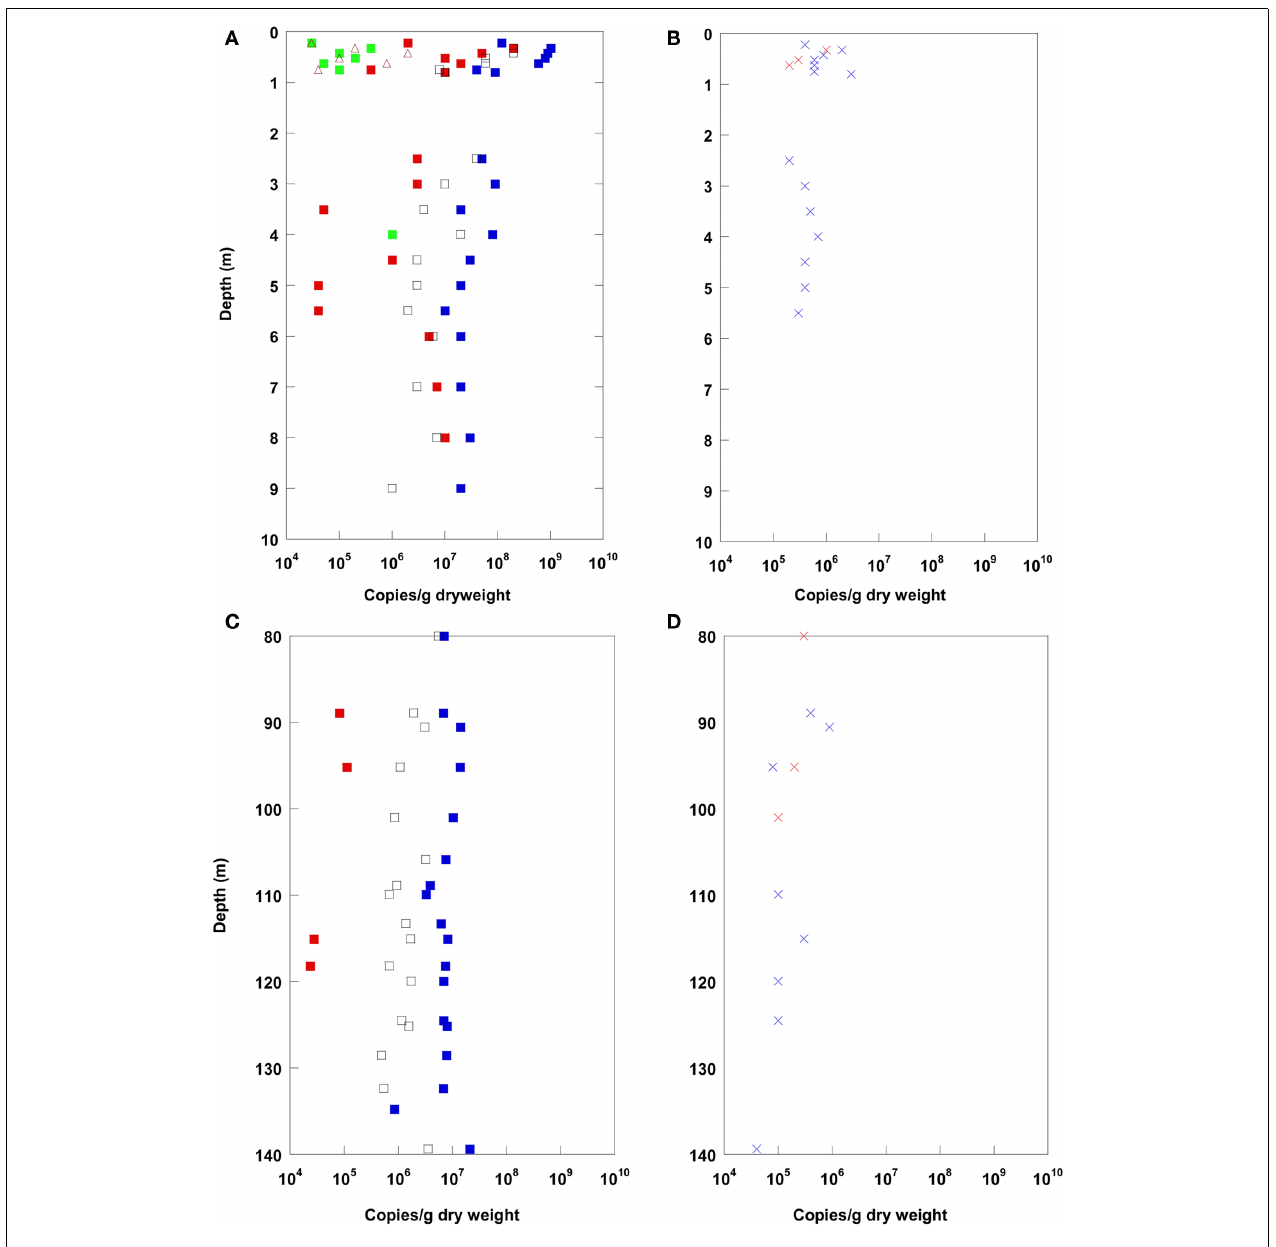
Bacteria , red: Archaea , green: Eukarya , brown: Geobacteriaceae , black: JS-1- Chloroflexi (A,C) ; functional genes, red: aprA , blue: cbbL (B,D)